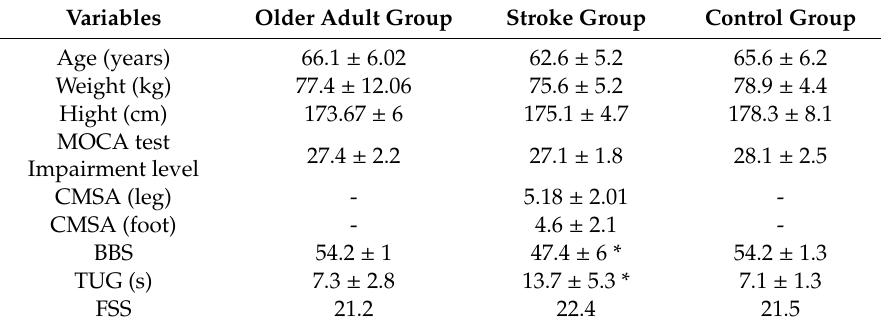
Table 1. Demographic trait and baseline clinical